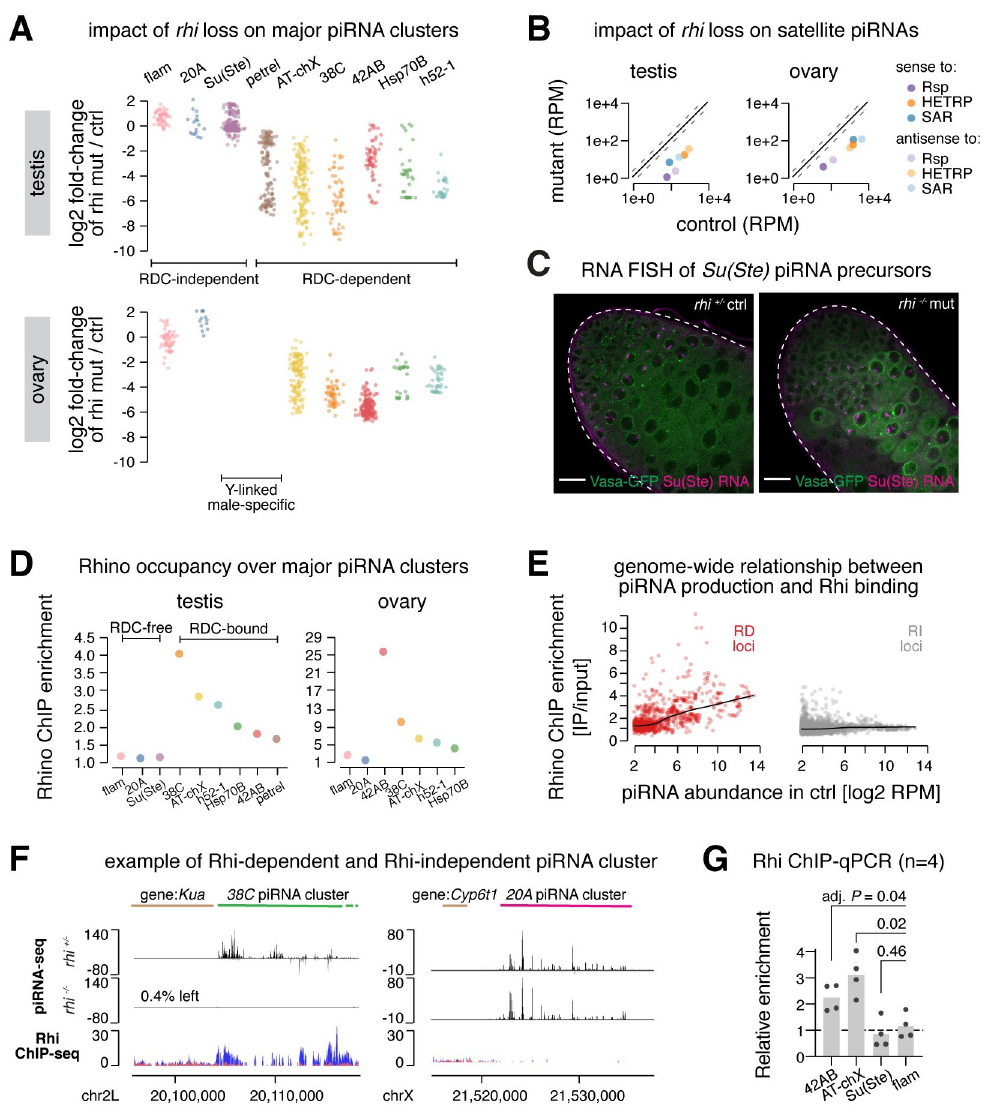
Fig 4. RDC complex is required for piRNA production from dual-strand piRNA clusters. (A) Impacts of rhi loss on piRNA production from major piRNA clusters in testis and ovary. Scatter plot showing fold-change of piRNA production from 1Kb genomic windows spanning major piRNA clusters in testis (top) and ovary (bottom), upon loss of rhi . Two Y- linked, male-specific clusters are not present in female genome. Each cluster is given a unique color. Averages of two biological replicates are shown. (B) Impact of rhi loss on piRNA production from satellite repeats in testis and ovary. Scatter plot showing levels of complex satellite-mapping piRNAs in rhi 2/KG mutant and control testis (left) and ovary (right). Each complex satellite is assigned a color, and piRNAs sense to satellite consensus are marked with higher opacity than antisense ones. Mean of two biological replicates is shown. (C) Unperturbed expression of Su(Ste) piRNA precursors in testes of rhi mutants. RNA fluorescence in situ hybridization of Su(Ste) piRNA precursors in rhi control (left) and rhi 2/KG mutant (right) testes that express Vasa-GFP. Scale bar: 20 μ m. (D) Rhi occupancy over major piRNA clusters in testis and ovary. Scatter plot showing Rhi ChIP-seq enrichment over major piRNA clusters in testis (left) and ovary (right). Shown are averages of two biological replicates. Two Y-linked, male-specific clusters are not present in female genome. Each cluster is colored the same way as in (A). (E) Scatter plot showing the relationship between Rhi ChIP enrichment and piRNA production over 1Kb genomic windows. Loci that show � 4-fold decline in piRNA production at the absence of rhi are defined as Rhi-dependent (“RD”, red), otherwise Rhi-independent (“RI”, gray). Each dot is the average of two biological replicates. Black lines show local regression. (F) Examples of Rhi-dependent ( 38C , left) and Rhi-independent ( 20A , right) piRNA clusters. piRNA-seq in rhi mutant and control testes are shown at the top, and Rhi ChIP-seq is shown at the bottom (blue: IP, red: input). The profile of a representative replicate is shown. (G) Rhi does not bind Su(Ste) cluster in testis. Bar graphs showing Rhi ChIP-qPCR (n = 4) over four piRNA clusters in testis. Adjusted P- values are from multiple t-tests corrected for multiple comparisons by the Holm-Sidak method. Uni-strand piRNA cluster flam not bound by Rhi serves as a negative